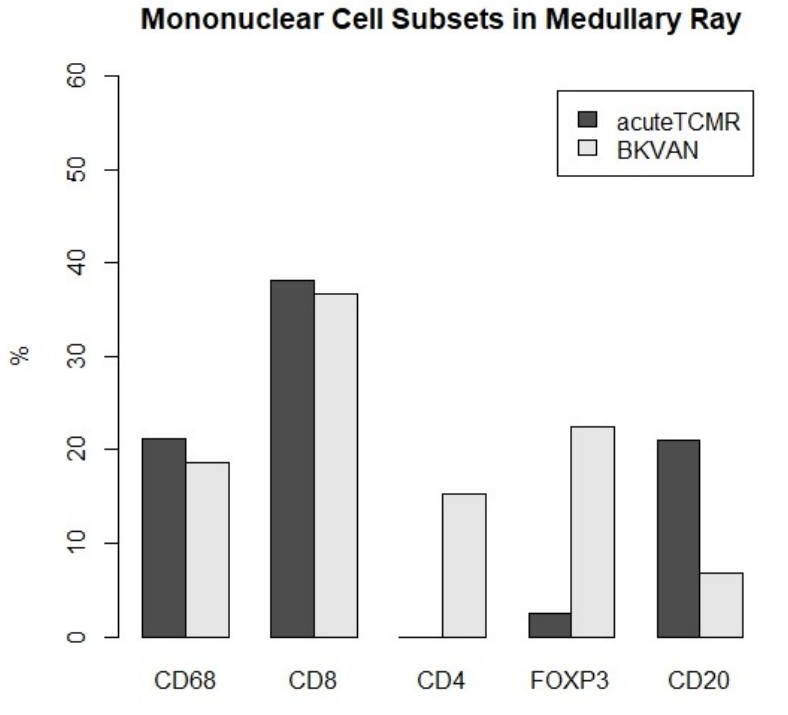
Figure 4. The proportions of mononuclear cell subsets for acute TCMR versus BKVAN cases in cor- tical interstitium. CD8+ cells were significantly more prevalent in TCMR than BKVAN cases ( p = 0.034).